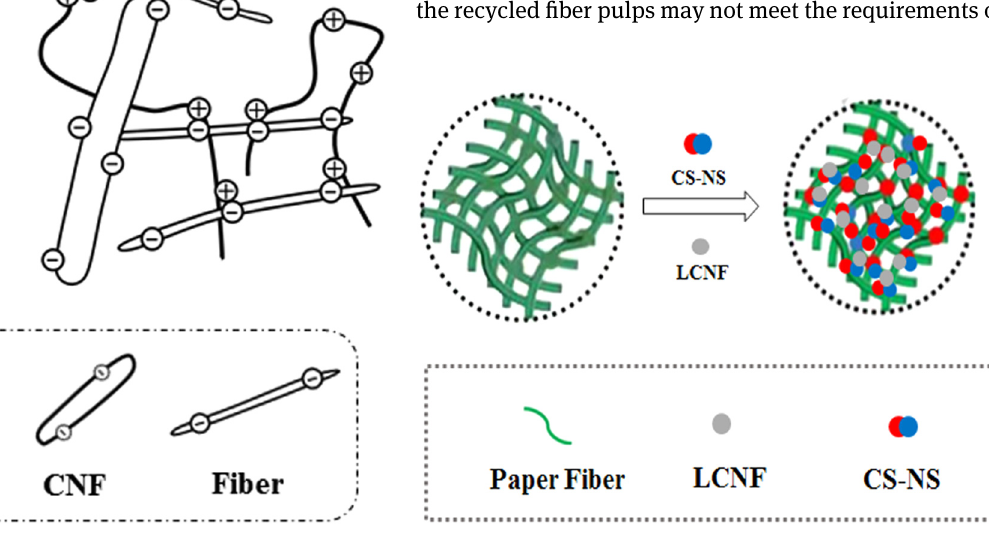
Figure 4: Charge angle and networking of paper matrix with NC composites.